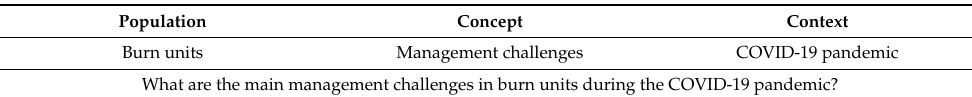
Table 1. Creation of the research question according to the PCC